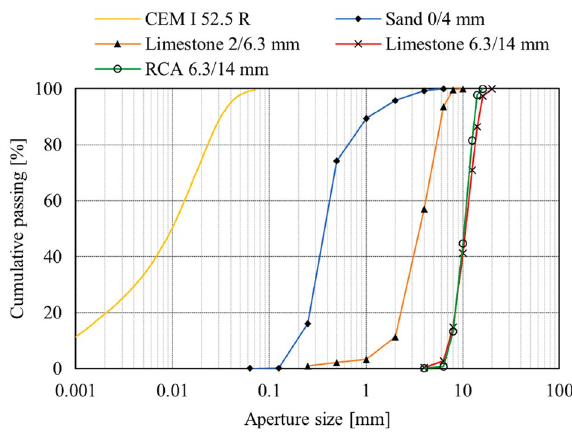
Figure 6. Particle size distribution curve 35 .